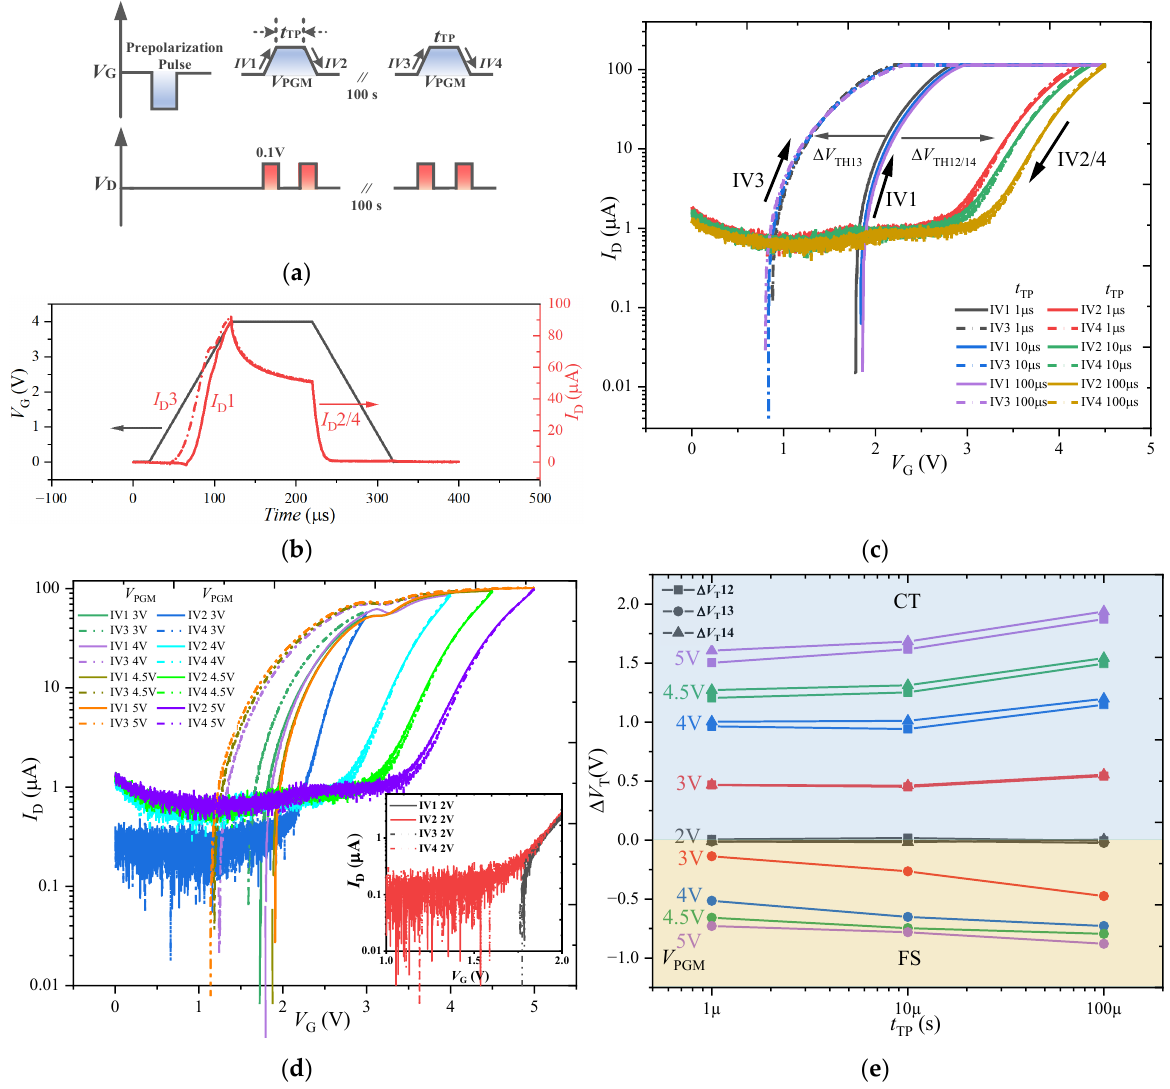
Figure 8. ( a ) Pulse sequence with two single pulses used for CT and FS competition test of the FeFET. ( b ) Transient current response of FeFET under two single pulses: I D 1 and I D 3 correspond to the rising edges IV 1 and IV 3, I D 2 and I D 4 correspond to the falling edges IV 2 and IV 4. I D - V G characteristics measured on the rising ( IV 1) and falling ( IV 2) edges of the first single-pulse and the rising ( IV 3) and falling ( IV 4) edges of the second single-pulse ( c ) with various pulse widths, and ( d ) with various pulse amplitudes. ( e ) Variation of ∆ V T with respect to t TP for various values of V PGM under two single